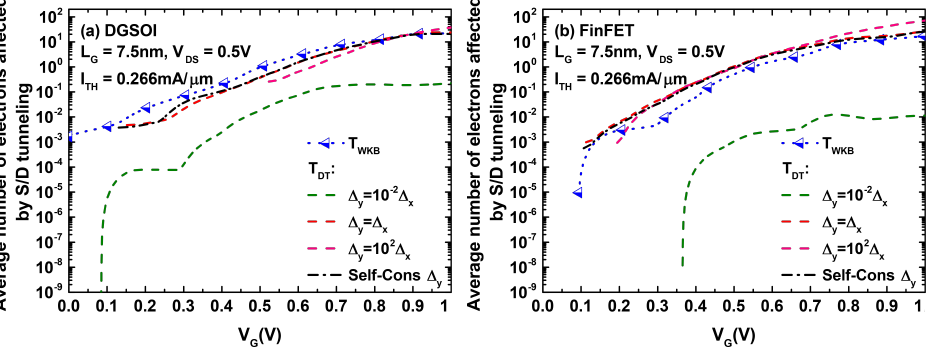
Figure 5. Average number of electrons (in arbitrary units) affected by S/D tunneling as a function of V G in the DGSOI ( a ) and the FinFET ( b ) with L G = 7.5 nm. The results compare the utilization of the WKB probability with respect to T DT with different choices of ∆ y (self-consistent and predefinedly dependent on ∆ x ).